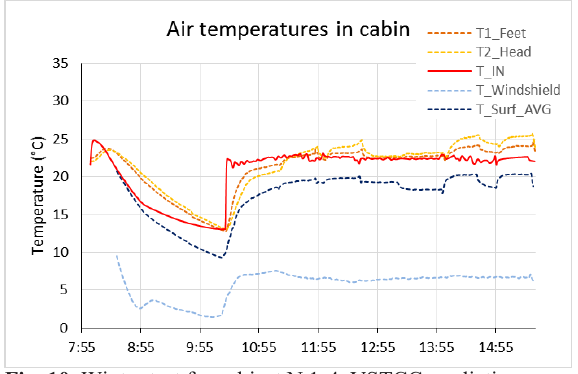
Fig. 10. Winter test for subject N.1-4. VSTCC prediction.